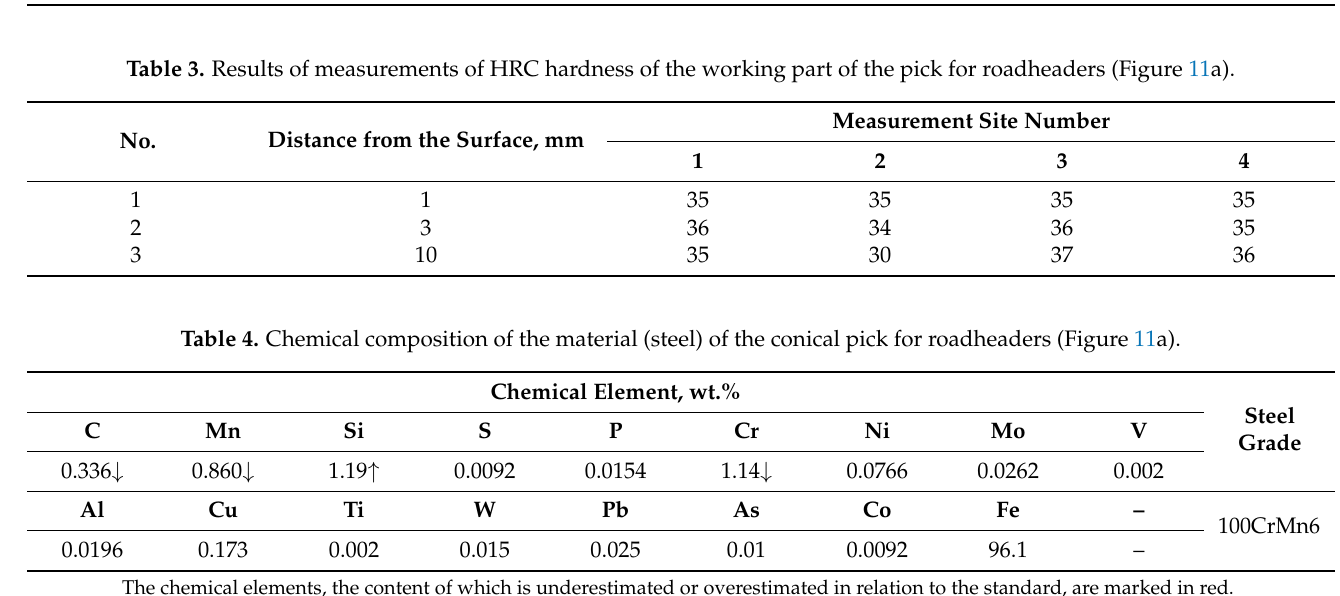
Table 2. Results of measurements of HRC hardness of the gripping part of the pick for roadheaders (Figure 11a). No.